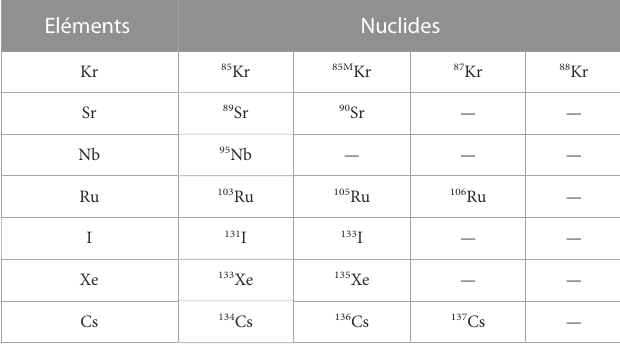
TABLE 1 List of 17 “ main ” radionuclides for severe accidents analysis.